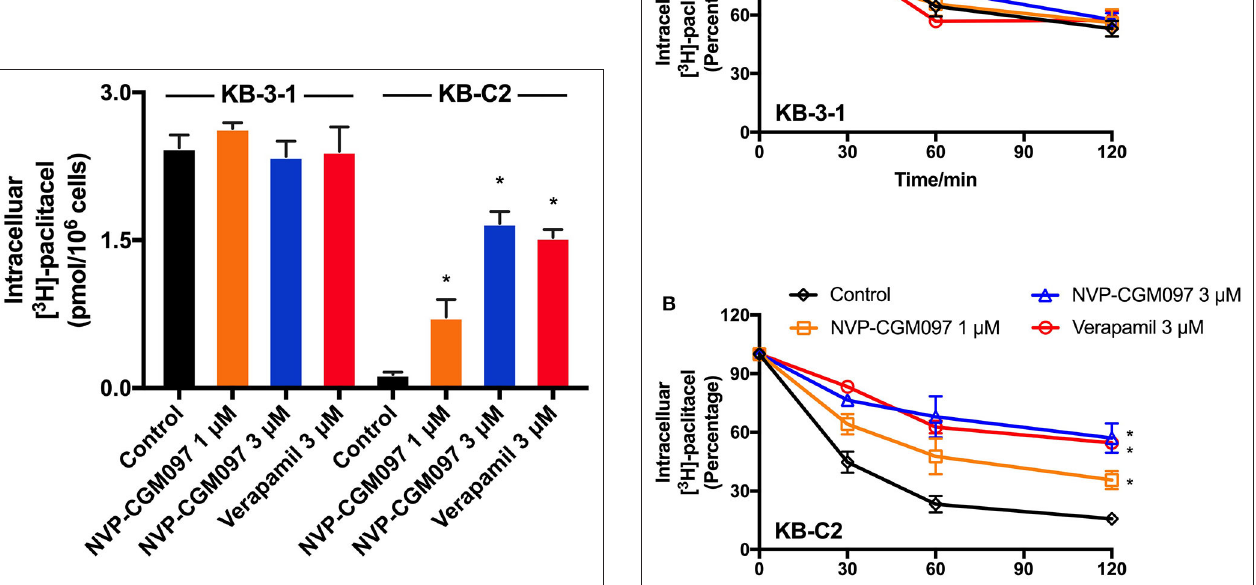
Frontiers in Oncology |